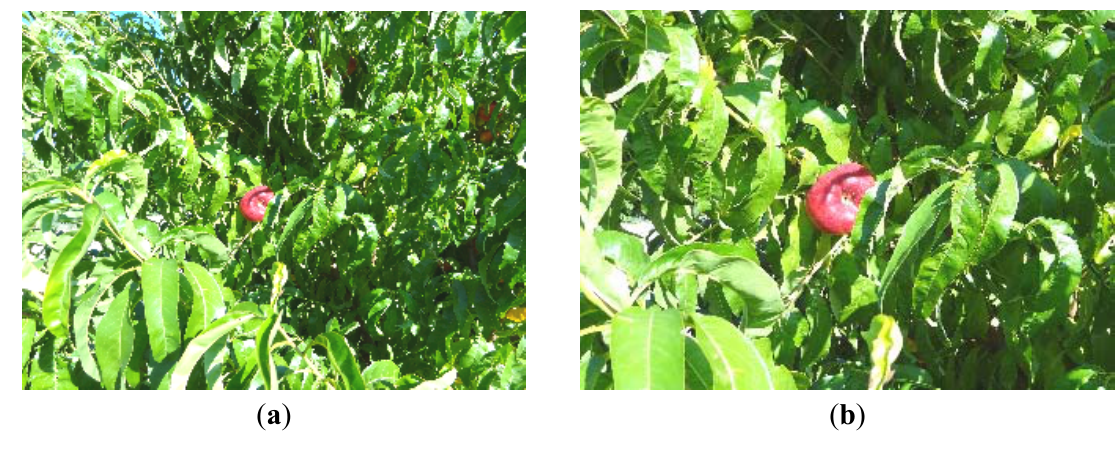
Figure 6. Orchard image (320 × 240 pixels, RGB565) obtained in normal ( a ) and zoom mode ( b